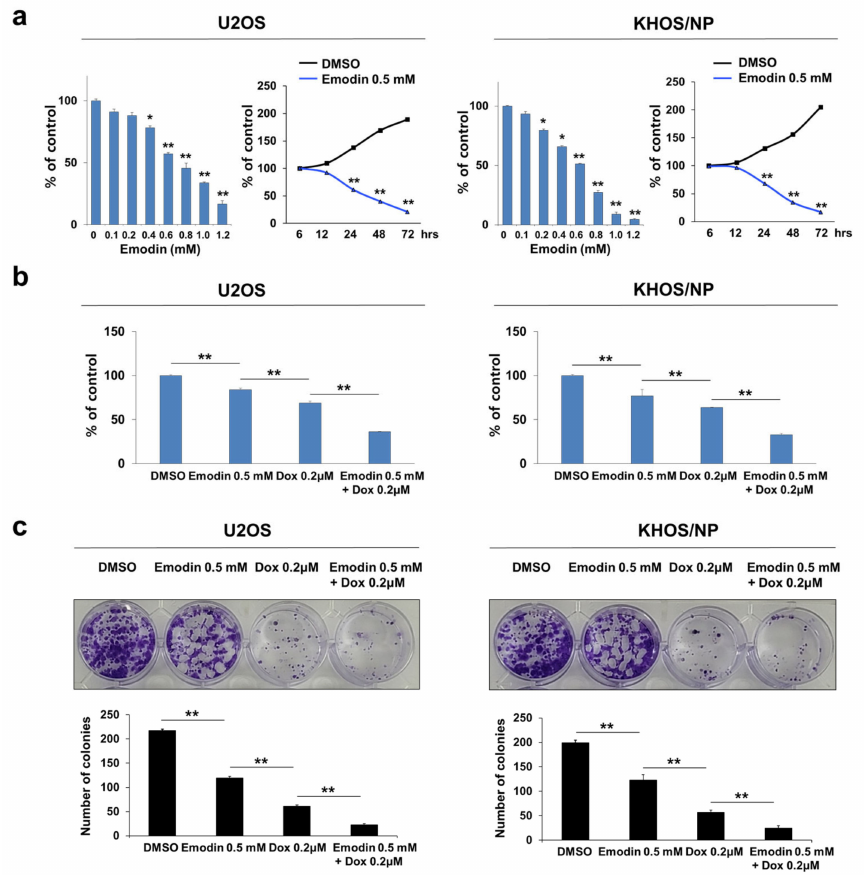
Figure 9. Co-treatment with CSNK2A1-inhibitor emodin potentiated the anti-proliferative effect of doxorubicin in osteosarcoma cells. ( a ) U2OS and KHOS/NP cells were treated with DMSO or 0.1~1.2 mM emodin, a CSNK2A1 inhibitor, for 24 h. In addition, U2OS and KHOS/NP cells were treated with DMSO or 0.5 mM emodin for 6, 12, 24, 48, and 72 h. The proliferation of cells was evaluated with a CCK8 proliferation assay. ( b ) U2OS and KHOS/NP cells treated with DMSO, 0.5 mM emodin, and 0.2 µ M doxorubicin or 0.5 mM emodin and 0.2 µ M doxorubicin for 24 h and evaluated with a CCK8 proliferation assay. ( c ) Colony-forming assays were performed with U2OS (1 × 10 3 ) and KHOS/NP (1 × 10 3 ) cells treated with DMSO, 0.5 mM emodin, and 0.2 µ M doxorubicin or 0.5 mM emodin and 0.2 µ M doxorubicin in 24-well culture plates. Clono-Counter software was used in the quantification of the number of colonies. *; p < 0.05, **; p <